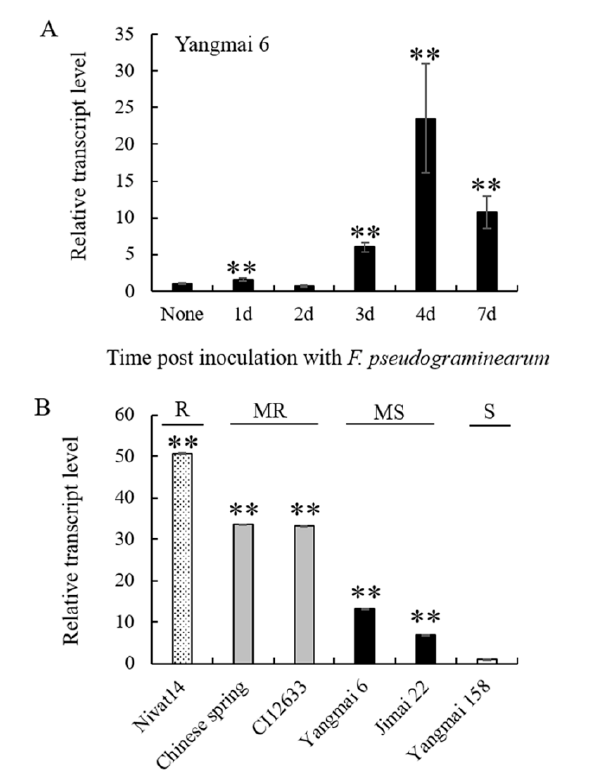
Figure 2. Transcript profiles of TaCRK-7A in the wheat response to F. pseudograminearum infection via qRT-PCR analysis. ( A ) TaCRK-7A transcript profile in the wheat cultivar Yangmai 6 levels at non-inoculation (none), 1, 2, 3, 4, and 7 d post inoculation with F. pseudograminearum strain WHF220. TaCRK-7A transcript level at none is set to 1. ( B ) Transcript patterns of TaCRK-7A in six wheat cultivars at 4 dpi with F. pseudograminearum WHF220. The gene transcript in the highly susceptible wheat cultivar Yangmai 158 was set to 1. R represents resistant wheat cv.; MR represents moderately resistant wheat cultivars; MS represents moderately susceptible wheat cultivars; S represents highly susceptible wheat cv.. TaActin was used as the internal control for gene expression. ** p < 0.01 (Student’s t -test) represents significant differences derived from three repeats. Bars indicate the standard deviation of the mean.